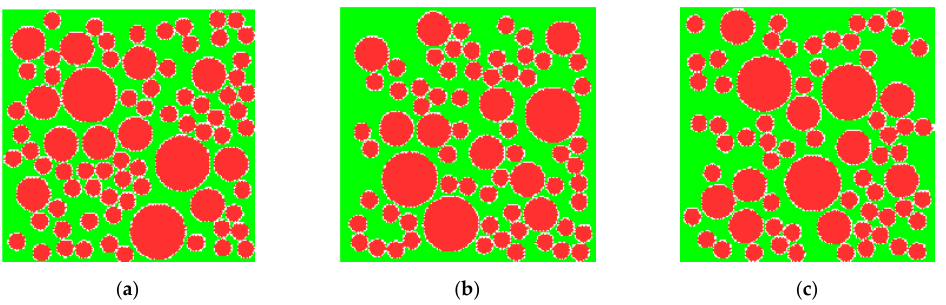
Figure 4. Random aggregate models of concrete. ( a ) Specimen 1; ( b ) specimen 2; ( c ) specimen 3.